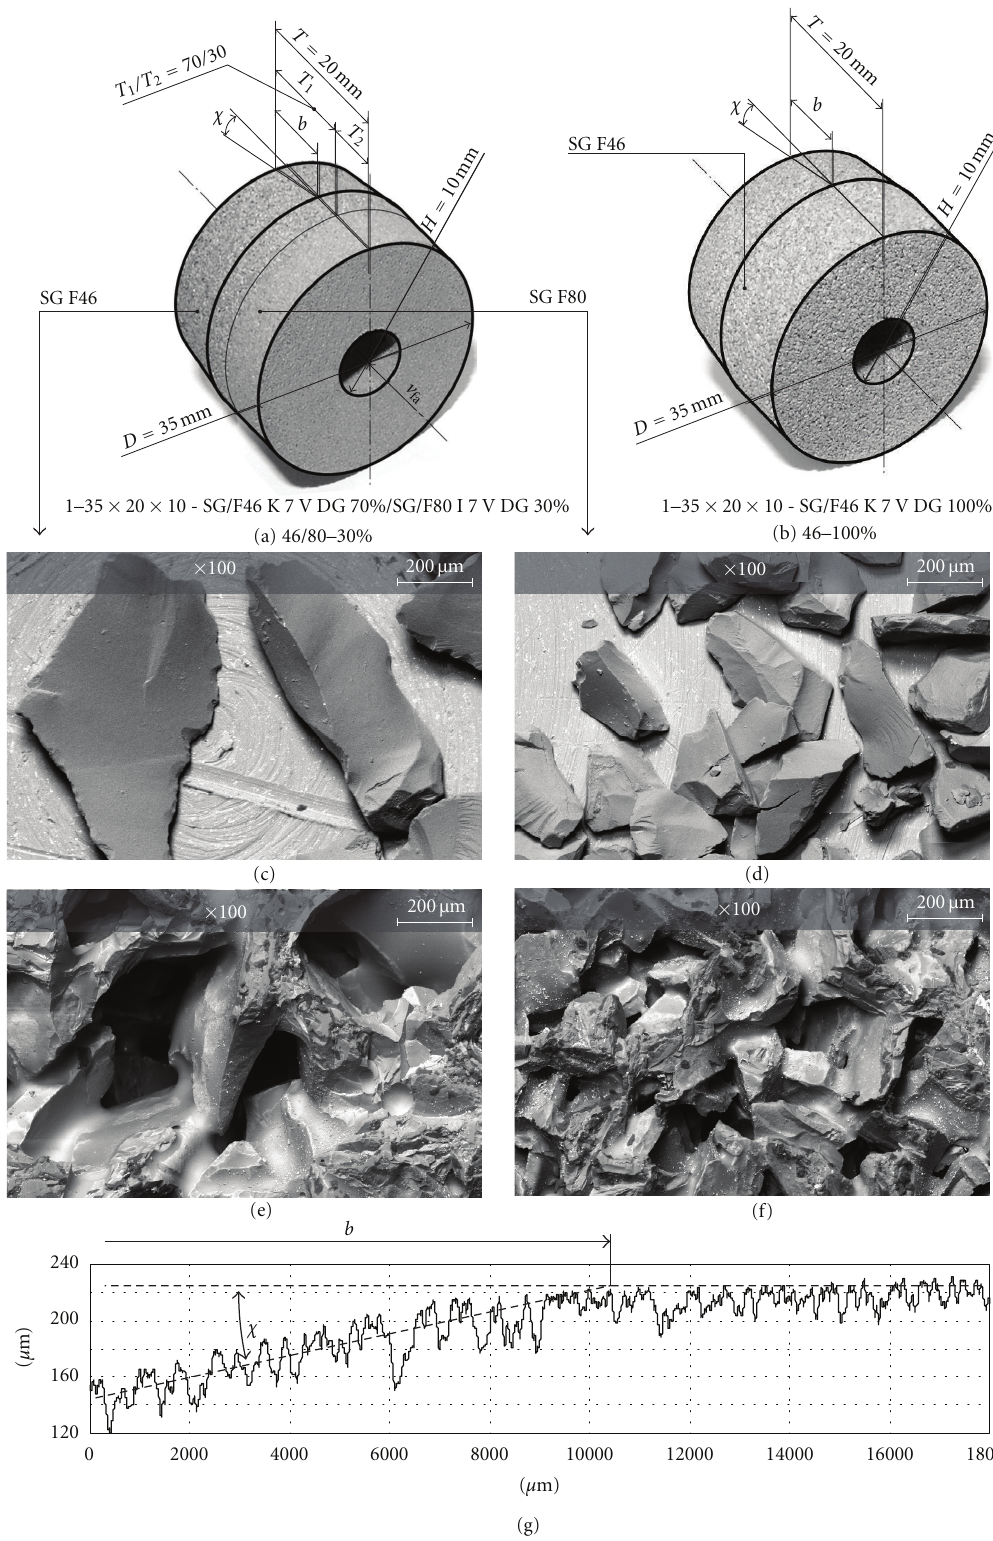
Figure 6: Grinding wheel with zone-diversified structure made of microcrystalline sintered corundum abrasive grains SG size 46 and 80: (a) construction scheme of grinding wheel with zone-diversified structure; (b) construction scheme of reference grinding wheel built of SG grains size 46; (c) microscopic view of SG grains size 46; (d) microscopic view of SG grains size 80; (e) microscopic view of the GWAS in conical zone of rough grinding; (f) microscopic view of the GWAS in cylindrical zone of finish grinding; (g) microgeometric axial profile of the grinding wheel active surface with an exposed conic